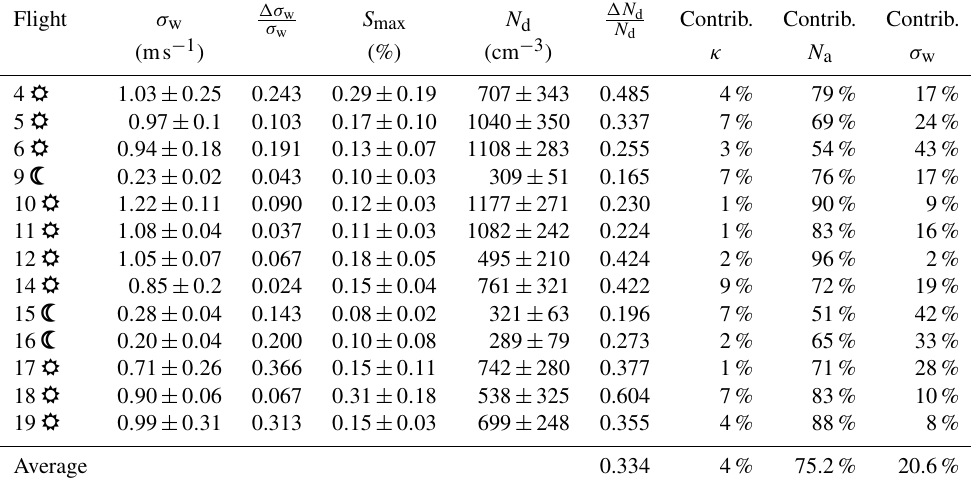
Table 4. Derived S max , N d , and σ w for all research flights along with the estimated contribution of each parameter to the variability of the droplet number. The symbol “ ” next to each flight number refers to a daytime flight, and “ ” refers to a nighttime